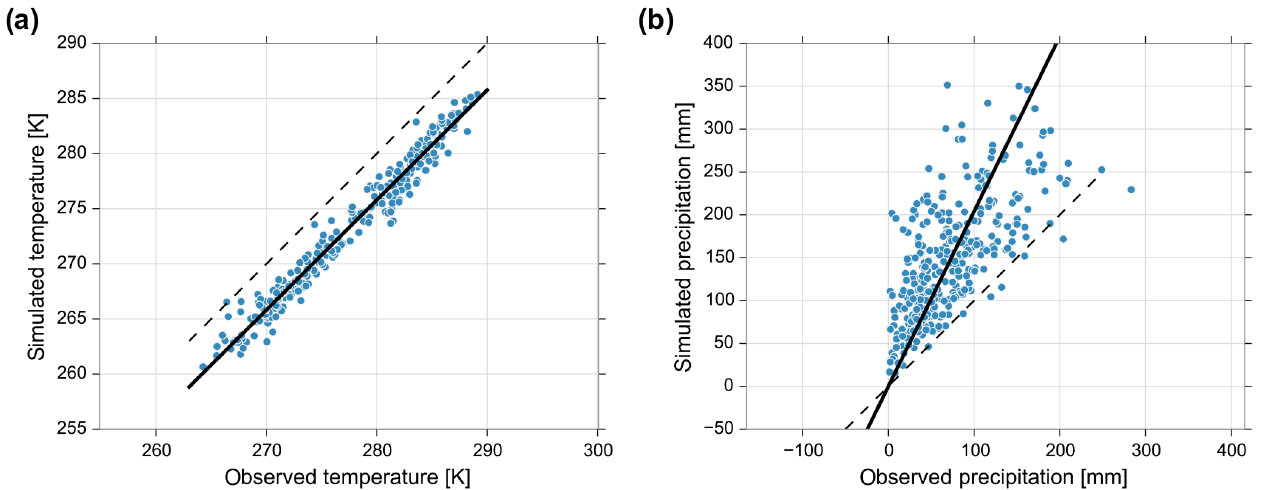
Figure 2. Scatter plots of modelled vs. observed temperature (a) and precipitation (b) . Each point represents the mean temperature and the precipitation depth of one month in the period 1986–2009, respectively. Besides the diagonal line (dashed), the regression line is also added to each plot